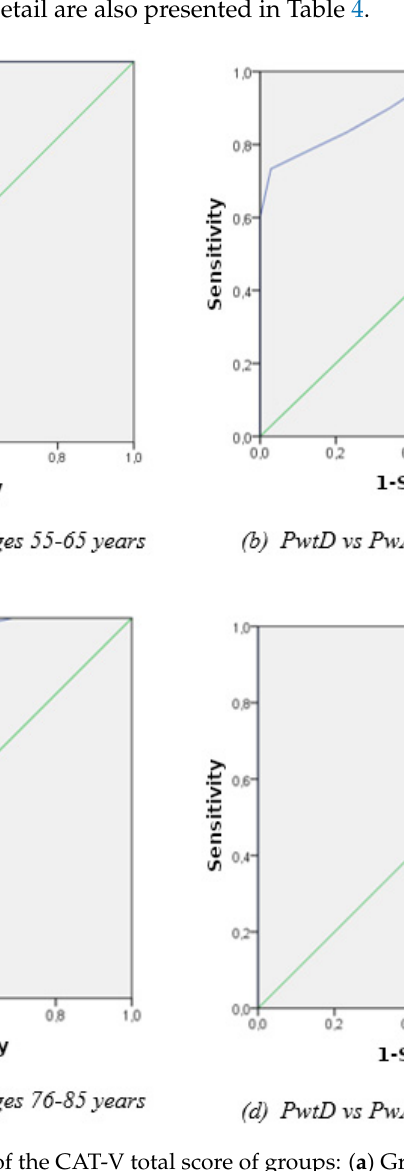
Figure 2. ROC curve analyses of the CAT-V total score of groups: ( a ) Group 1 (55–65 years of age), ( b ) Group 2 (66–75 years of age), ( c ) Group 3 (76–85 years of age), ( d ) Group 4 (86–95 years of age). Table 4. Diagnostic CAT-V classification between people without Alzheimer’s disease dementia (PwtD), and people with Alzheimer’s disease dementia